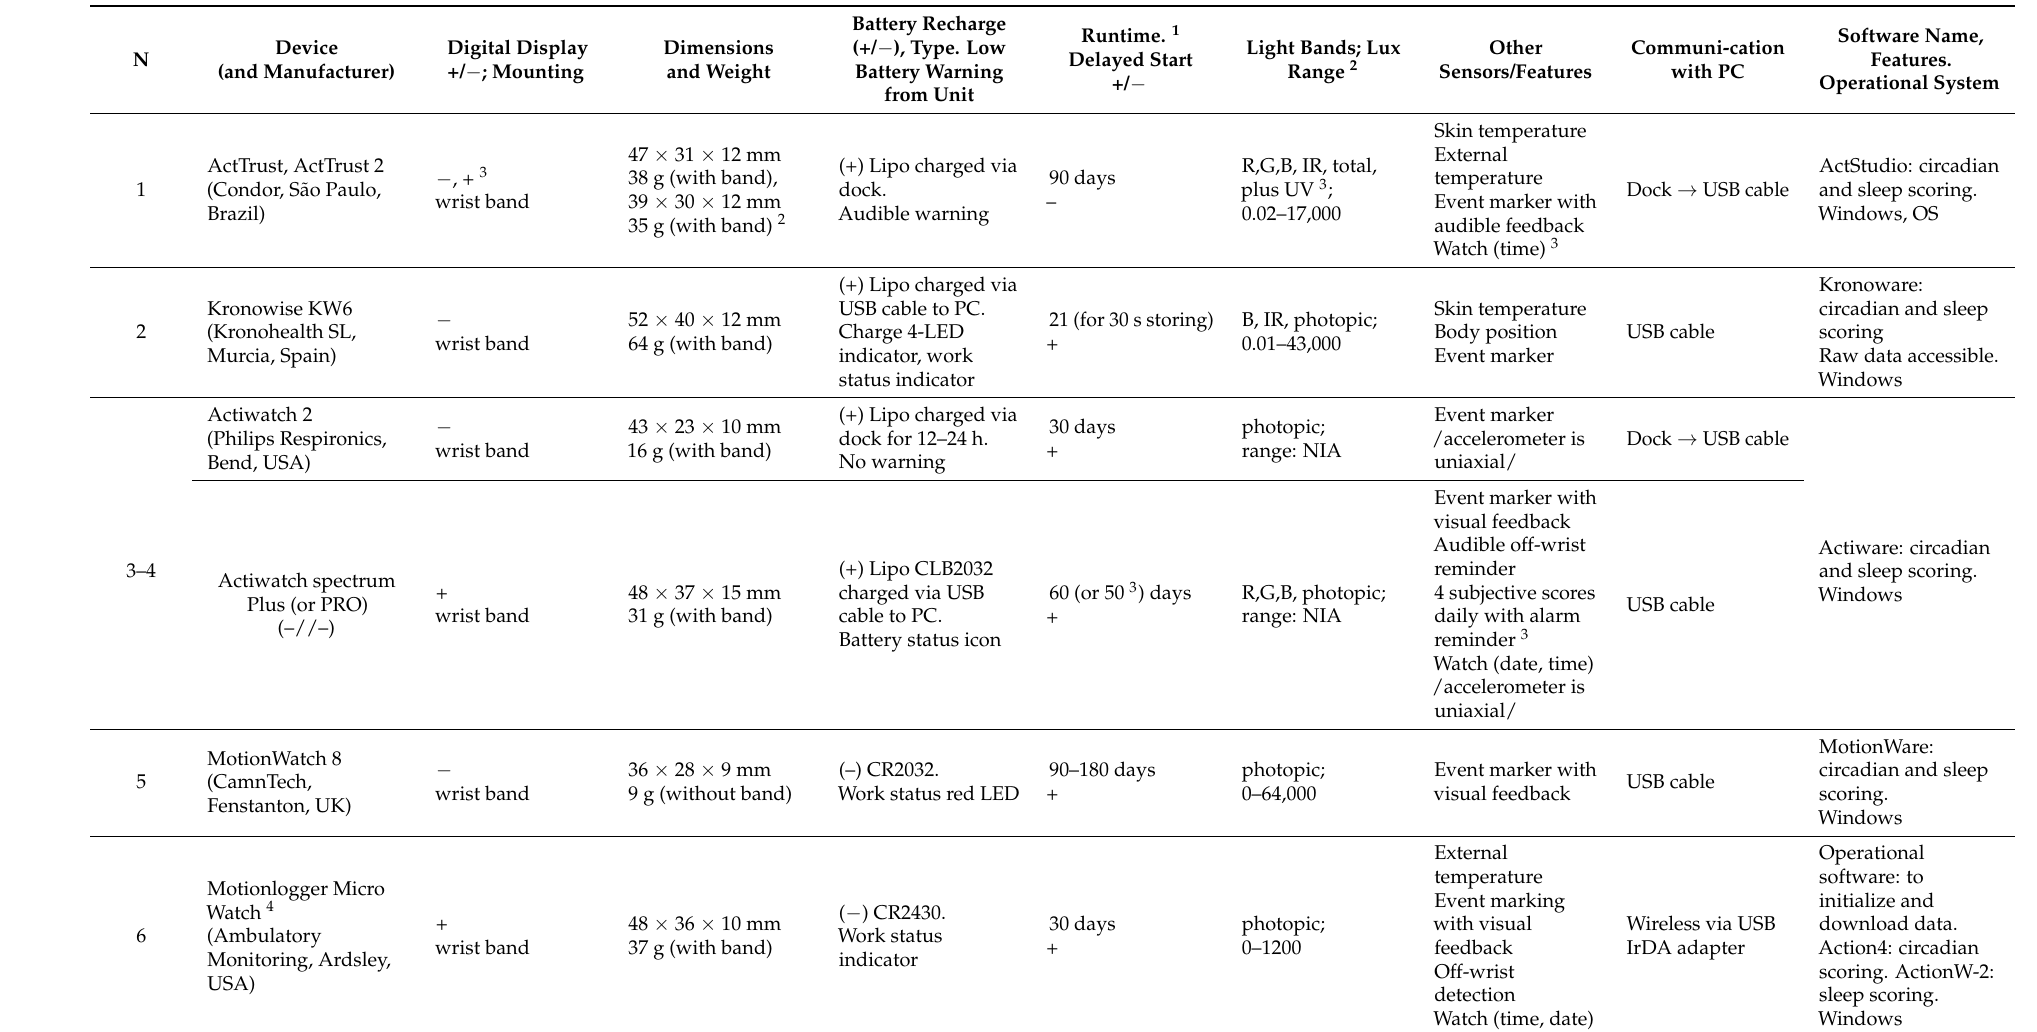
Table 1. Light-and-motion dataloggers for human research (as of October